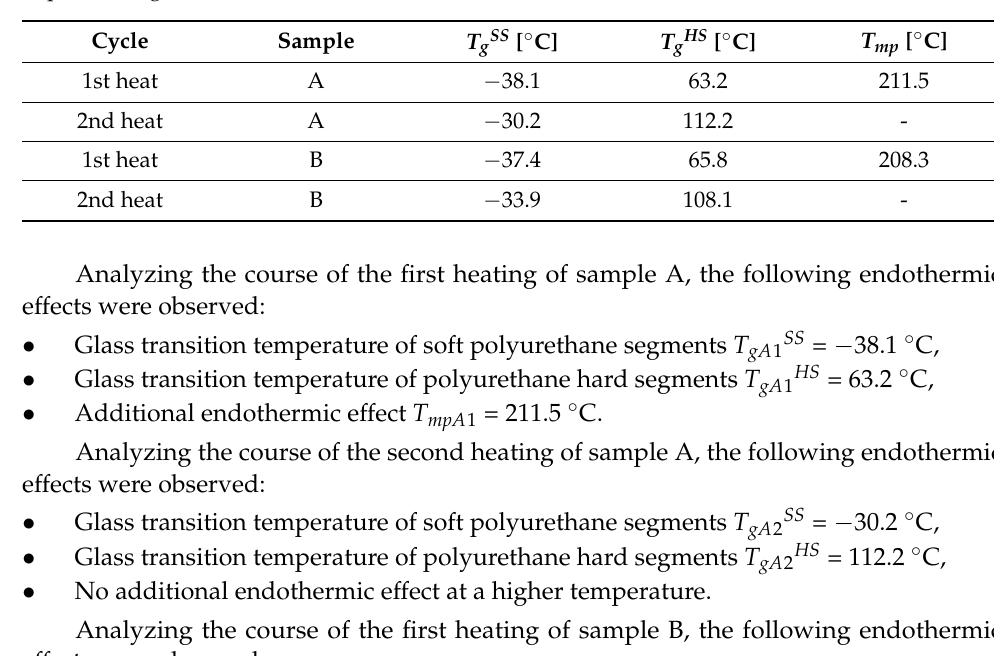
Figure 13. DSC curves in the full range of test temperature values ( a ) and approximately per range corresponding to the welding temperature values T w ( b ). Table 5. Glass transition temperature T g and additive endothermic effect temperature T mp (softening of plasticizing